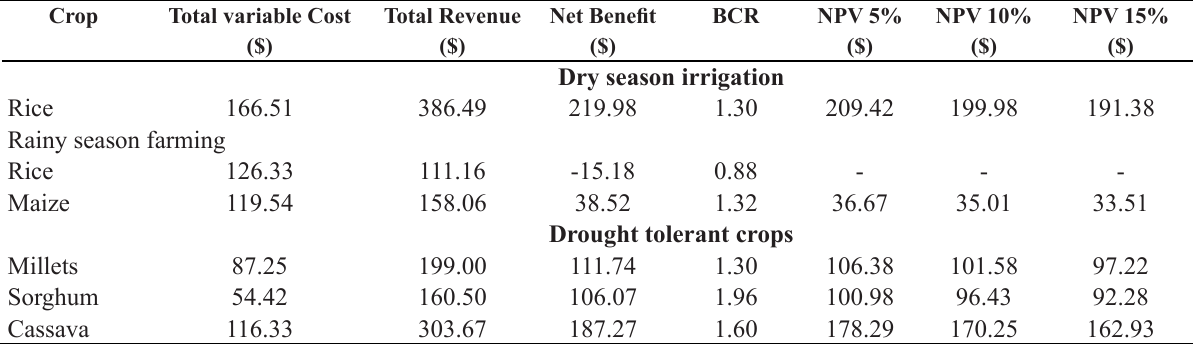
Table 2: Benefit Cost Ratio, Net Present Value and Internal Rate of Returns for Irrigated and Drought Tolerant